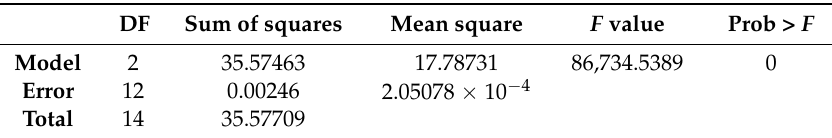
Table 6. Overall analysis of variance of tensile strength.